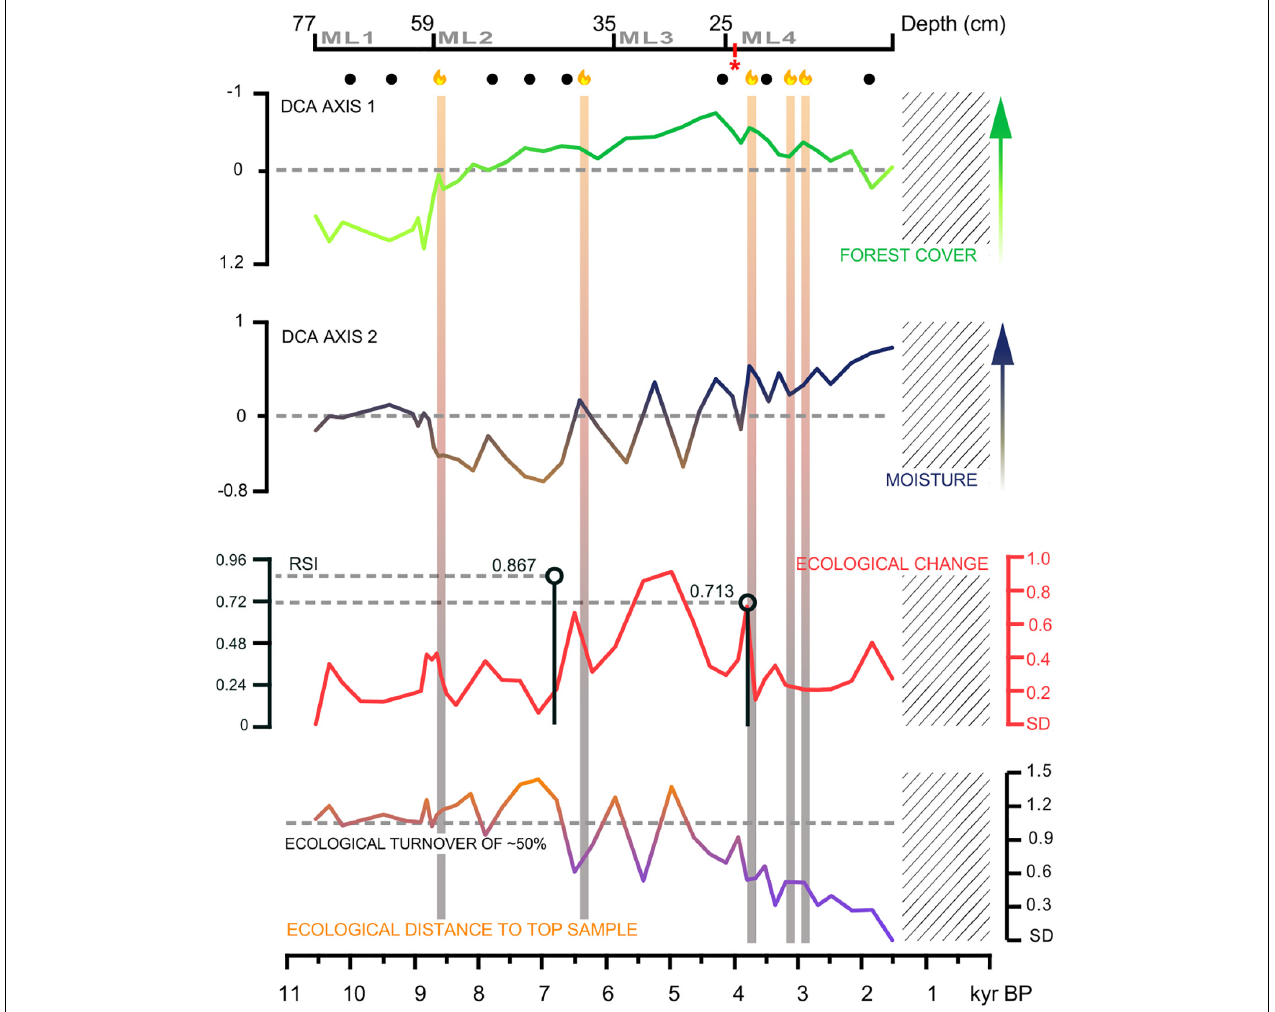
FIGURE 7 | DCA scores and ecological change metrics presented as number of Standard Deviations (SD) and plotted against time for MAR19-II record from Monquentiva. The two top panels show DCA ordination axis scores for Axis 1 and Axis 2. The arrows indicate interpreted environmental variables. The third panel shows Euclidean distance calculated between consecutive samples and used as a metric for ecological change. The black lines indicate significant shifts identified with the Regime Shift Index (RSI) derived from the STARS method (Rodionov, 2004). The bottom panel shows Euclidean distance calculated between the top sample in MAR19-II and all other samples, used as a metric for ecological similarity. The dashed line represents SD = 1 and indicates an ecological turnover of 50%. The color intensity represents the relative magnitude of ecological turnover, with purple indicating the most novel plant communities. The vertical bars highlight fire peaks from CharAnalysis (Higuera et al., 2009), with fire flames indicating local fires and black dots indicating regional fire peaks. The lattice denotes a gap in the MAR19-II sedimentary record. The red * indicates one sample where the pollen count was below 300 grains and reached 258 grains.